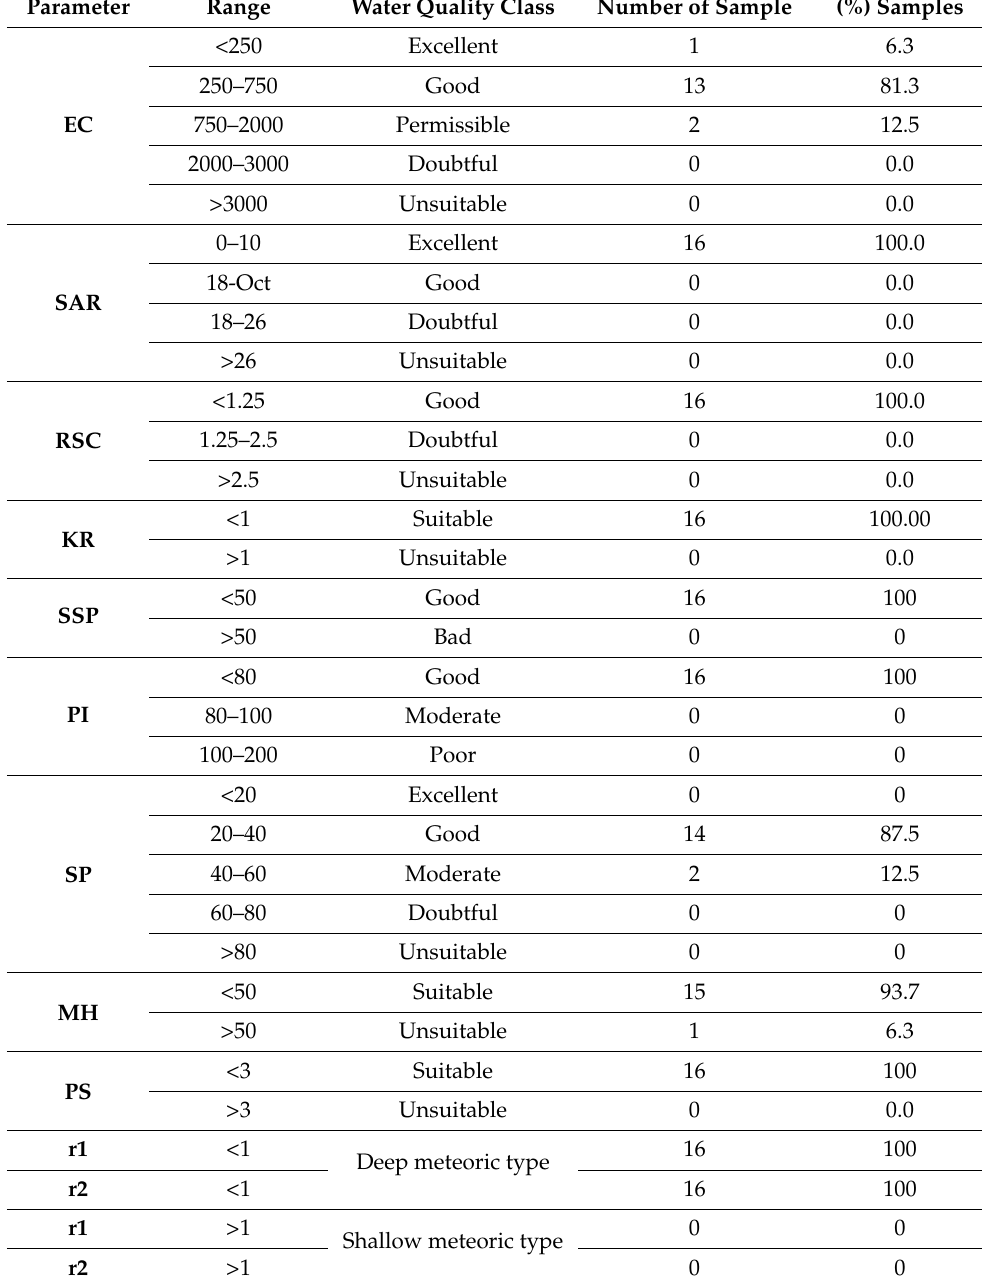
Table 5. Classification of the spring and well water samples for irrigation purposes based on various irrigation